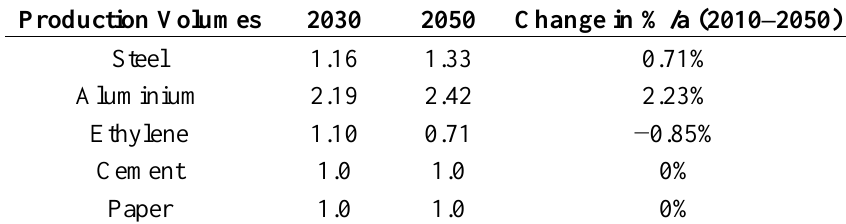
Table 5. Breakdown of production volume development from 2010 to 2050 for the intermediate industrial GVA growth path (Index 2010 = 1). Source: own calculation based on [35] and validated by industry stakeholders (except for